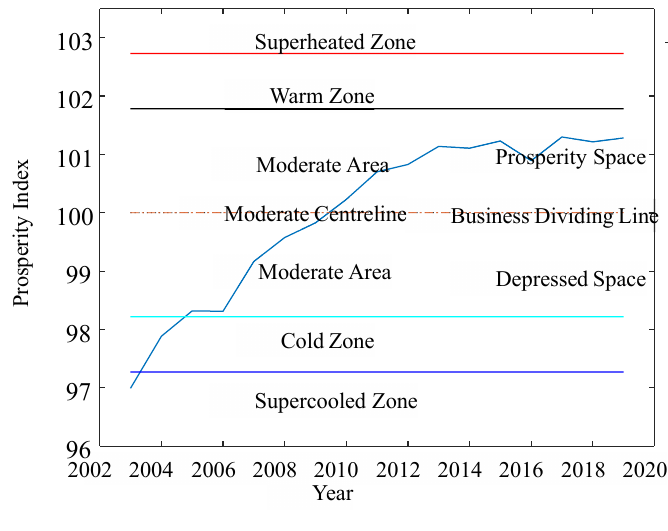
Figure 2. Composite index curve of China ’ s marine